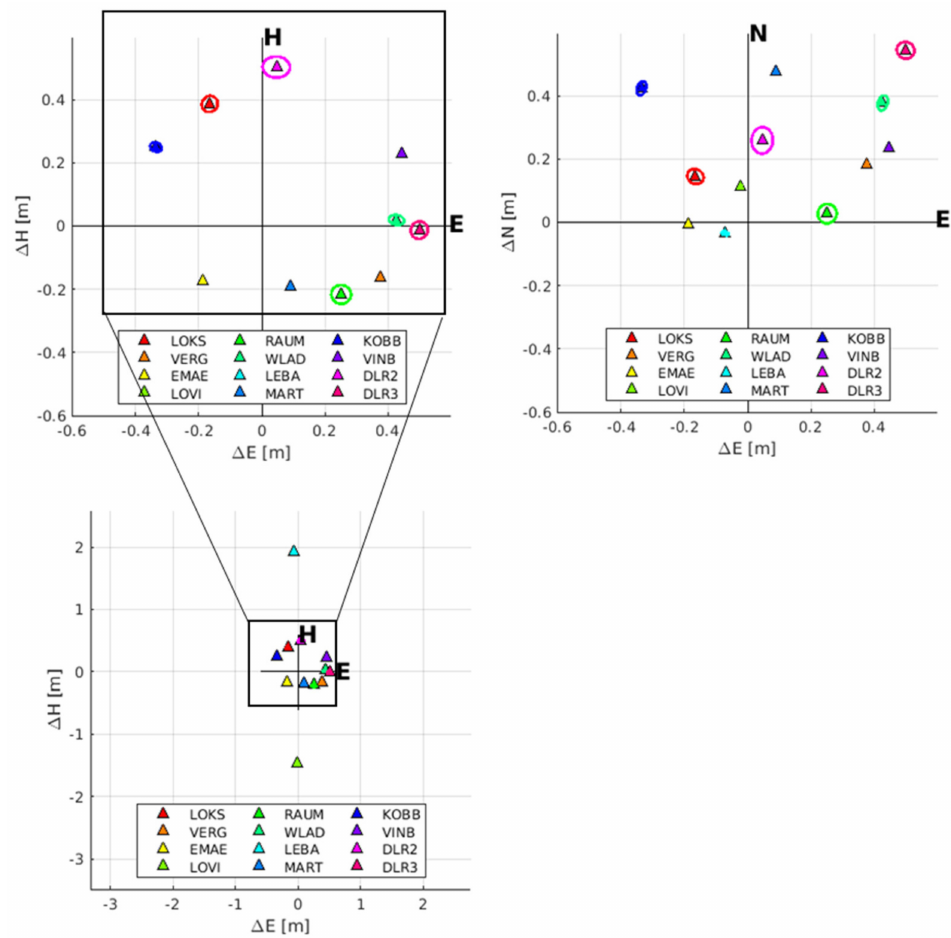
Figure 5. Confidence ellipsoids in local east/height ( top left ), zoomed out local east/height ( bottom left ), and local north/east ( right ) coordinates of all ECR stations using all available observations from 2020. The center position of the ellipsoids is given with respect to reference coordinates, previously measured by GNSS campaigns and therefore represent offsets with respect to reference